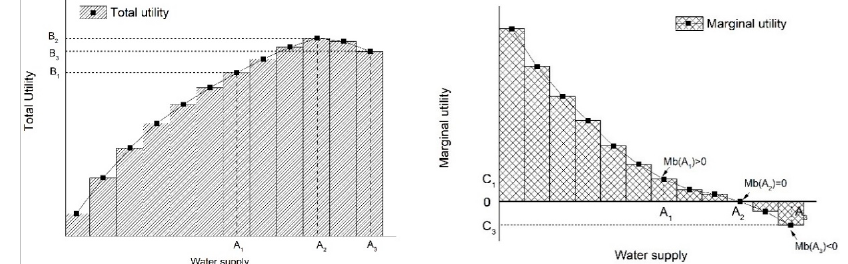
Figure 1. The benefit and marginal utility curves of agricultural water supply.